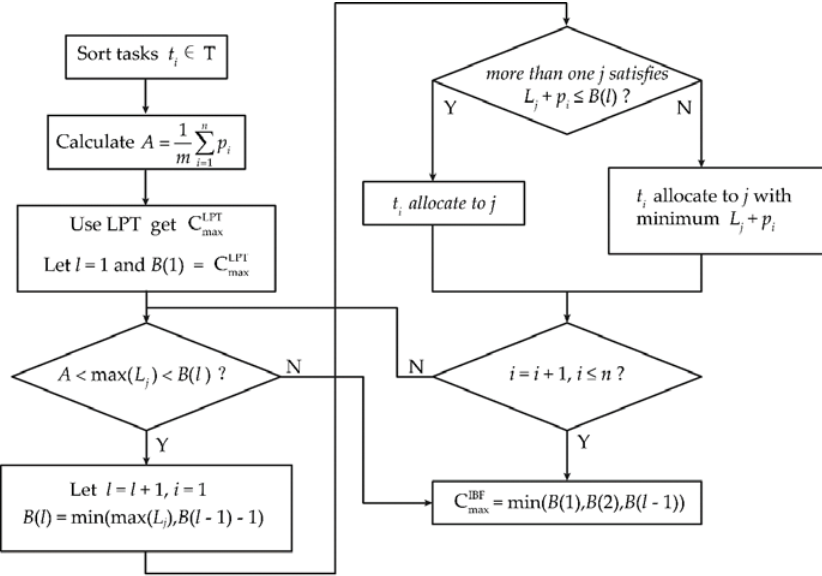
Figure 6. Improved bound fit algorithm (IBF) flowchart. LPT: longest processing time algorithm.